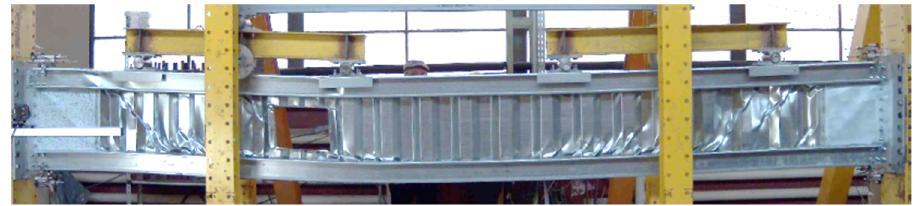
Figure 7. Deformed shape of the CWB-CMT-WO assembled by MIG brazing.